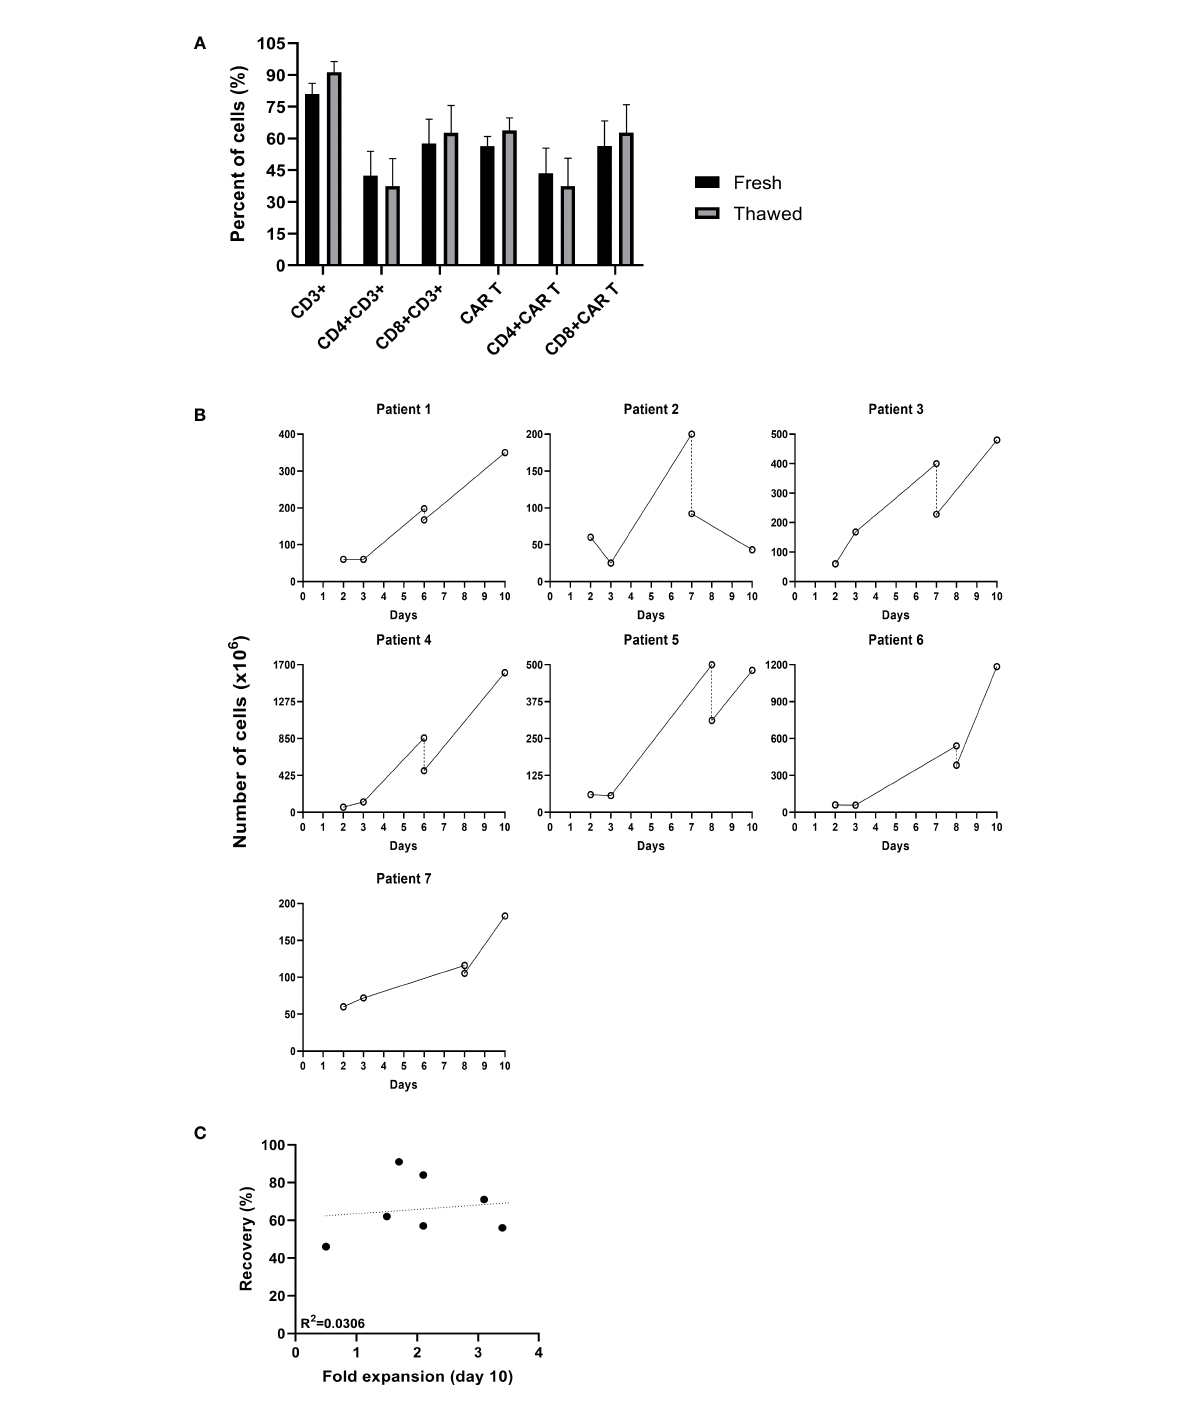
FIGURE 2 Comparison of cultures that were cryopreserved during the production process. (A) Phenotype analysis of fresh CAR T cells before cryopreserved and after thawing determined by fl ow cytometry (n=7). (B) Cell numbers (x10 6 ) from transduction to infusion. ( – ; day of cryopreservation). (C) Spearman ’ s rho correlation between the recovery after thawing and the fold expansion achieved by day 10 of the production process